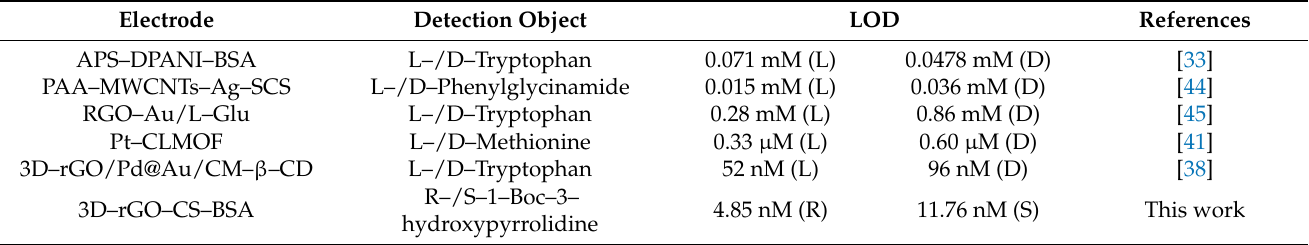
Figure 11. DPV of R–enantiomer ( A ) and S–enantiomer ( B ) at various concentrations in 0.1 M KCl containing 5 mM [Fe(CN) 6 ] 4 − /3 − solution; ( C ) linearity of peak current versus concentration of R–en- antiomer and S–enantiomer at di ff erent concentrations.